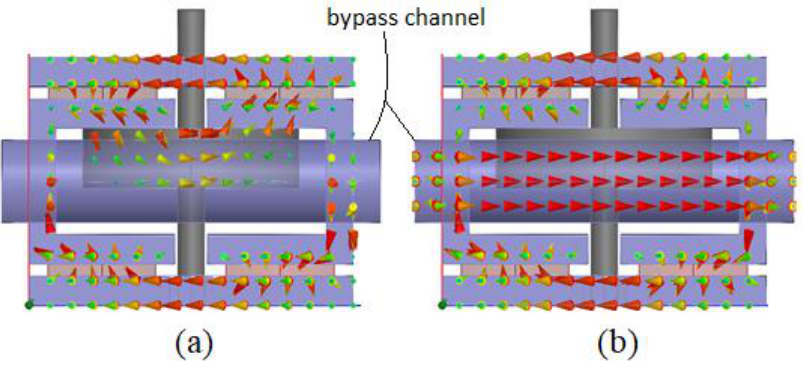
Figure 2. Magnetic circuit diagram of hybrid PMEMV: ( a ) without current; ( b ) with current [15].